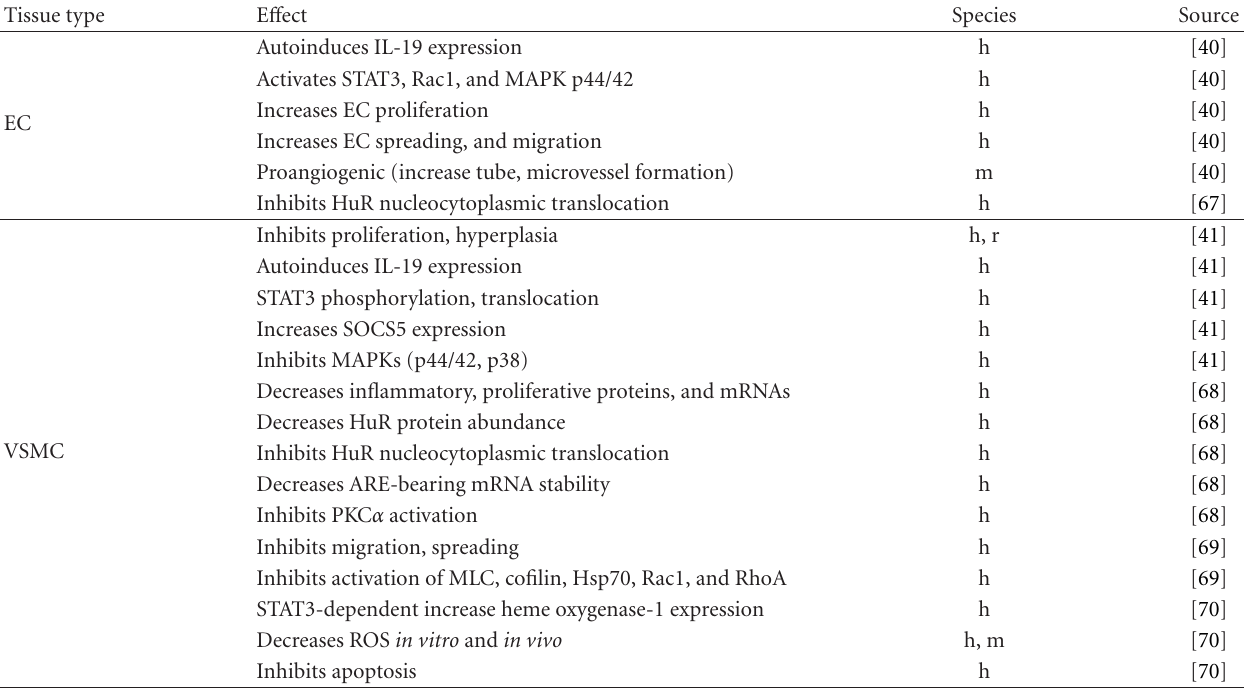
Table 2: E ff ects of IL-19 on resident vascular